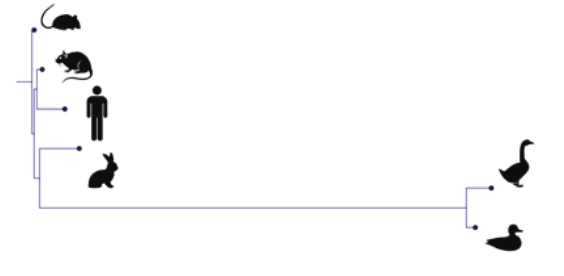
Figure 2: Phylogenetic tree based on the amino acids sequence of melanin-concentrating hormone (MCH). [Length of lines shows the degree of difference in 6 species compared to the sequence of mouse MCH].